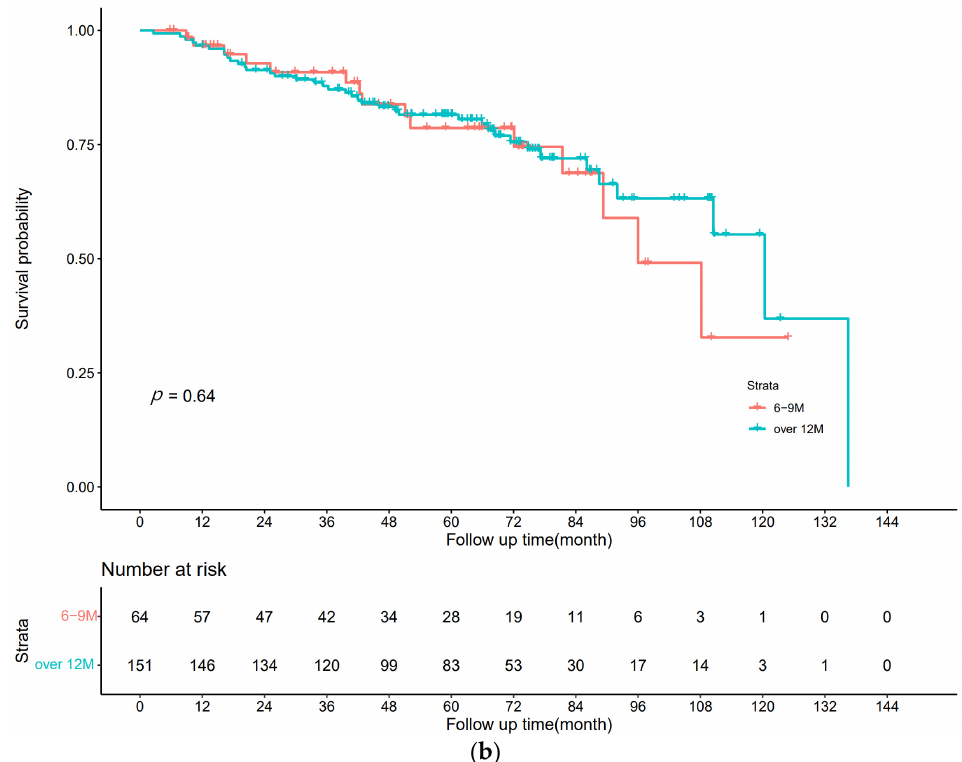
Figure 1. DFS. ( a ) Stage III CRC; ( b ) high-risk stage II